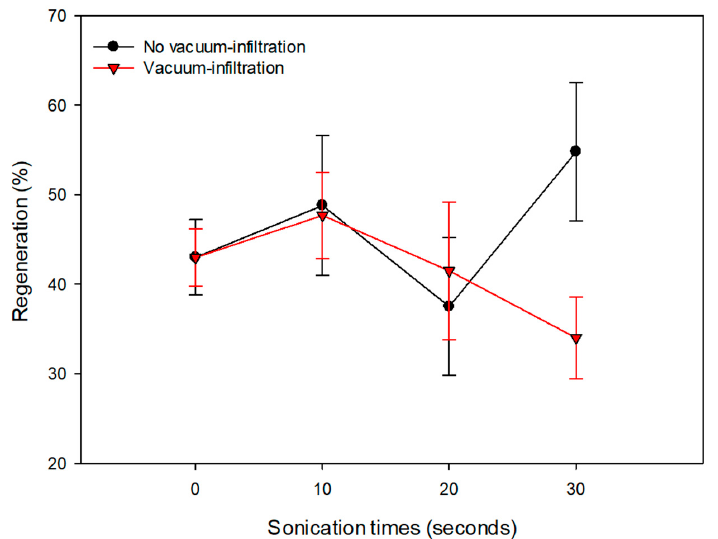
Figure 3. Effect of sonication treatments alone and combined with 20 min of vacuum-infiltration on adventitious shoot regeneration from hypocotyls slices of non-infected ‘Canino’ mature seeds. Data were collected six weeks after the beginning of the experiments.